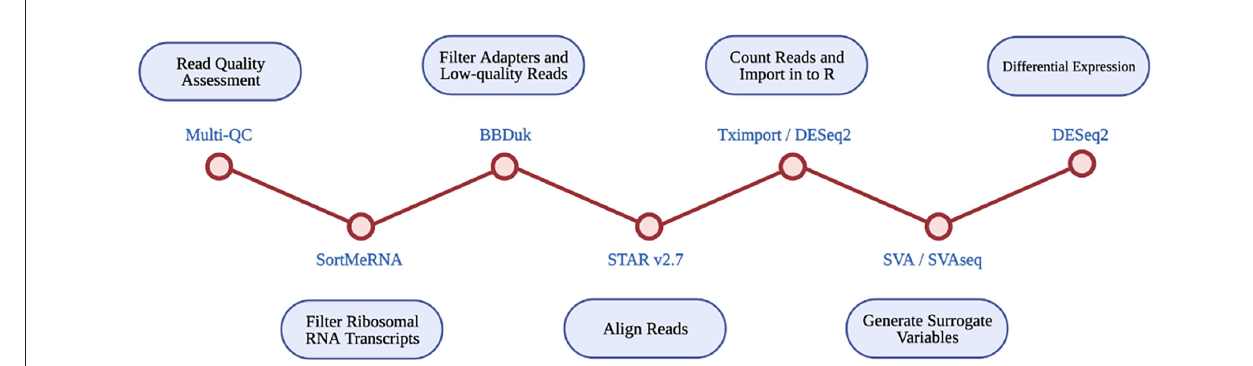
FIGURE1 Diagrammatic representation of RNA-seq differential expression pipeline. Each RNA-seq step is shown in the blue circles, with the tool used at each step given beside each red circle.